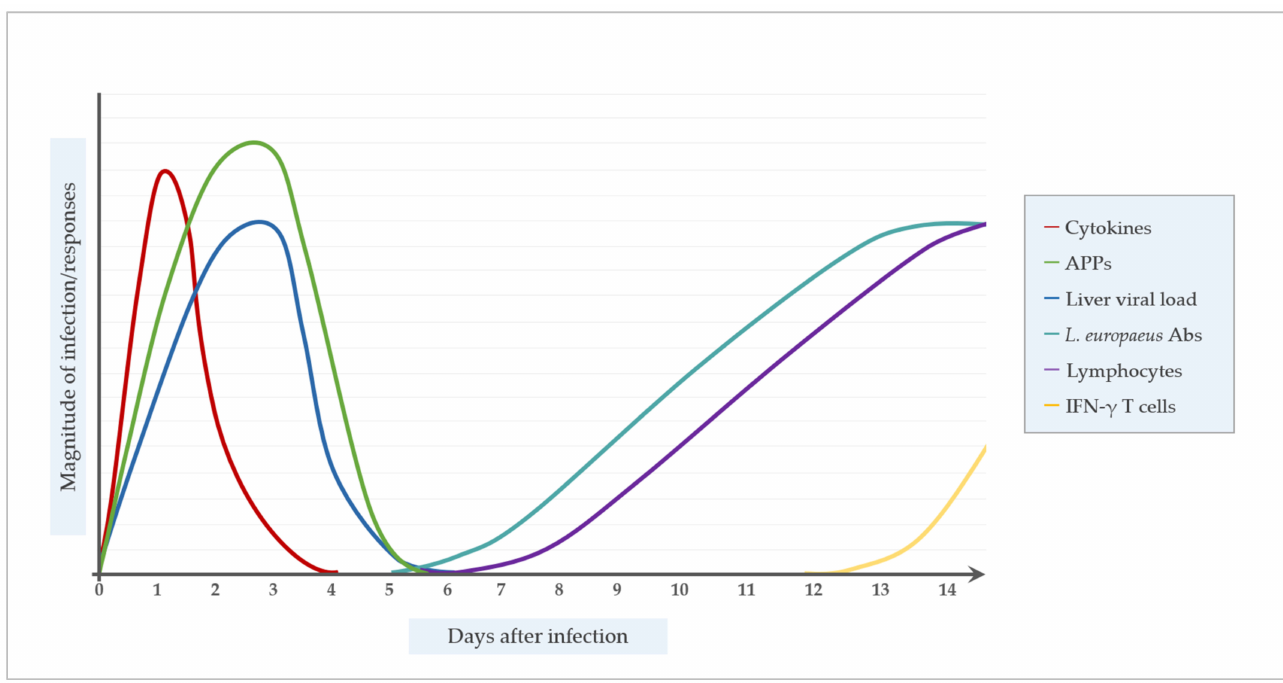
Figure 2. Temporal dynamic of the immune response after Lagovirus europaeus infection.; APPs, acute phase proteins; L. europaeus Abs, Lagovirus europaeus